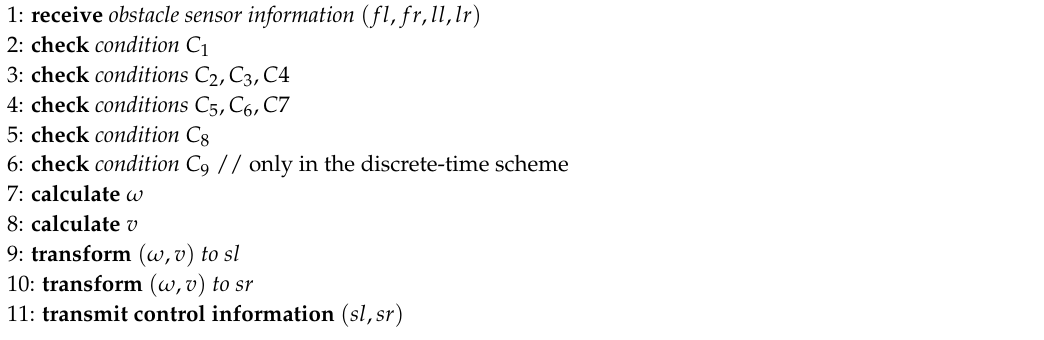
Algorithm A3 Pseudocode of the OA algorithm in the controller